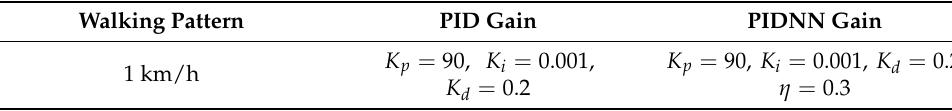
Table 3. Controller parameter in the walking pattern of 1 km/h ( η = learning